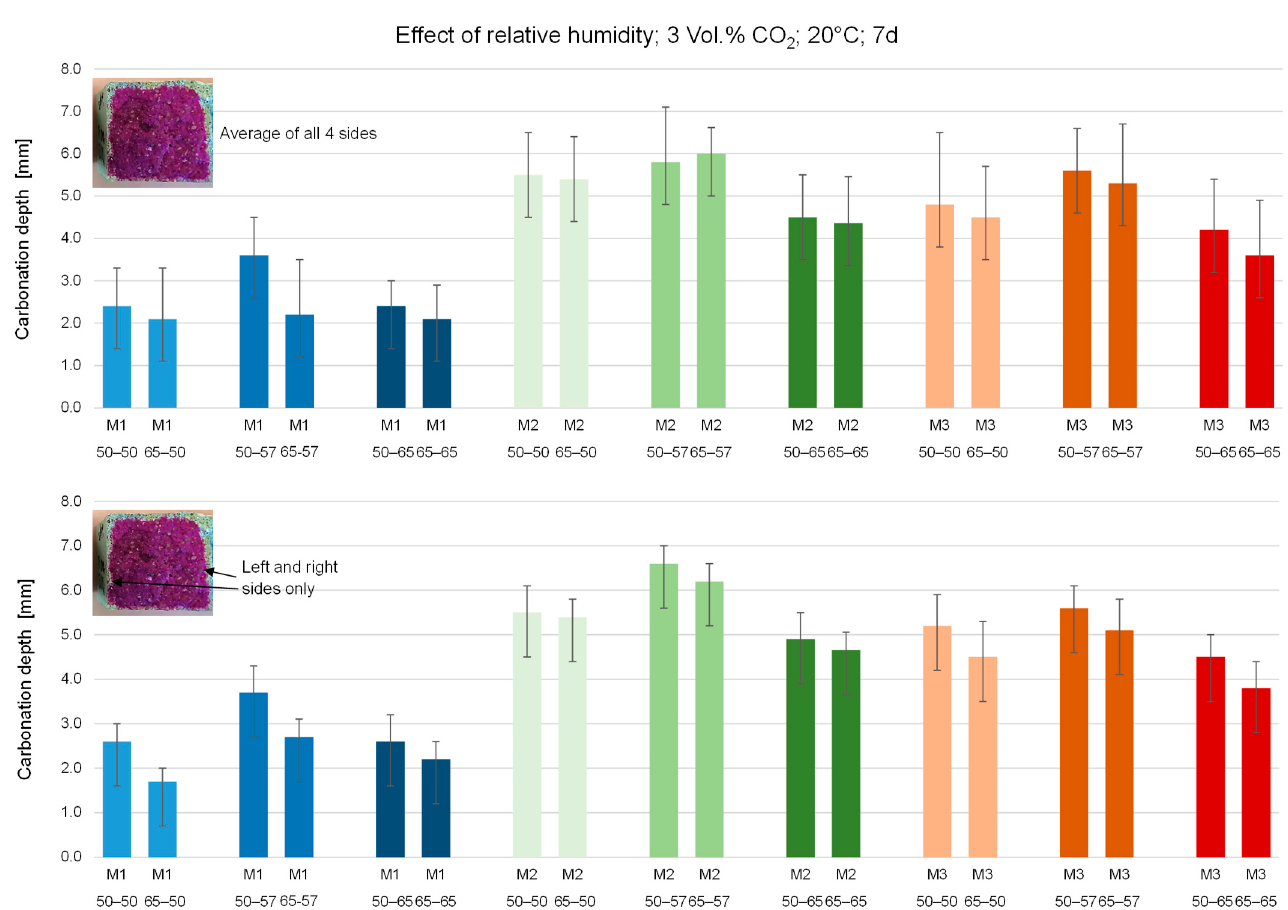
Figure 5. ( Top ): Carbonation depth determined at 7 d for accelerated conditions at 3% CO 2 —readings on all four sides of the freshly broken specimen surface (see picture top left); ( bottom ): carbonation depth determined at 7 d for accelerated conditions at 3% CO 2 —readings only on left and right sides of the specimen. Sample labelling: Mx-aa-bb: x = binder type, aa = Relative humidity during pre-conditioning, bb = Relative humidity during carbonation.